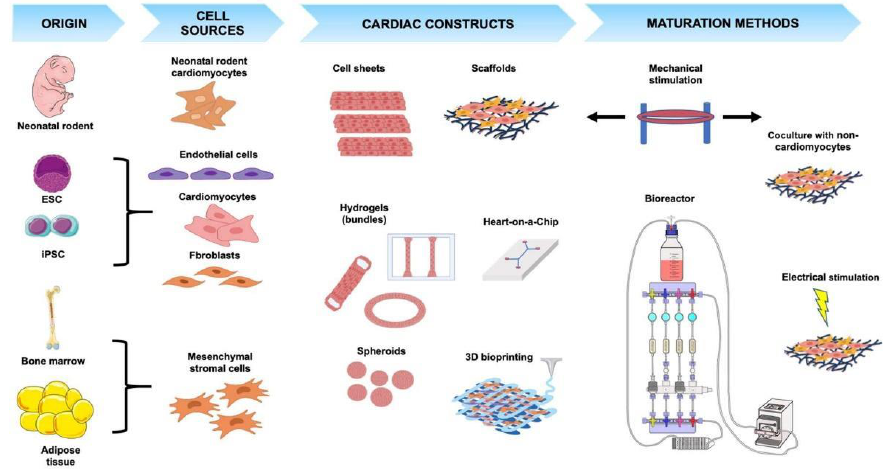
Figure 1. Main types of cell sources, cardiac constructs and maturation methods used in CTE. The cell types most frequently used as source for CTE include neonatal rodent cardiomyocytes, ESC-or iPSC-derived endothelial cells, cardiomyocytes and fibroblasts, and mesenchymal stromal cells derived from bone marrow or adipose tissue. Different systems have been developed to generate ECT including cell sheets, scaffolds, hydrogels, bundles, spheroids, heart-on-a-chip, and 3D-bioprinted constructs. The main methods used to increase maturation of cardiac constructs comprise mechanical and/or electrical stimulation, co-culturing with non-myocyte cells and continuous perfusion within bioreactors. See main text for details. Figure created with BioRender.com and